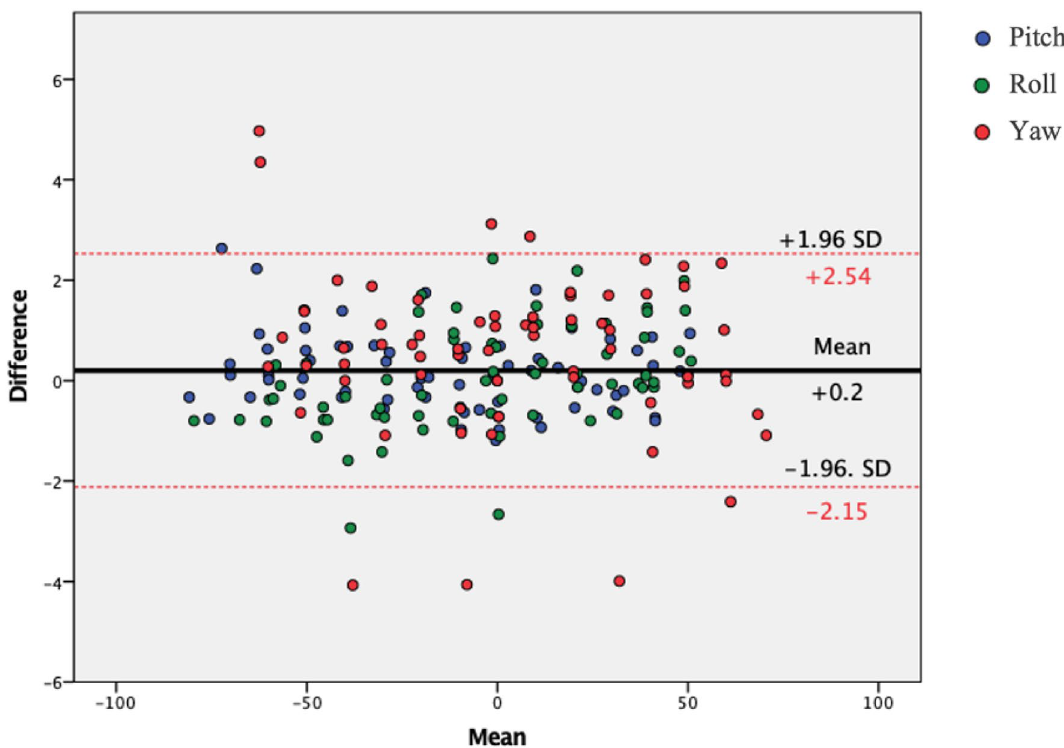
Figure 4. Bland–Altman plot between the cervical range of motion device and inertial measurement unit in vivo The X axis represent the mean between the cervical range of motion device and the inertial measurement unit and the Y axis the mean differences between them. Red lines indicate the 95% confidence intervals, and the black line indicates the mean of the differences. Blue points represent the Pitch, green points the Roll and red points the